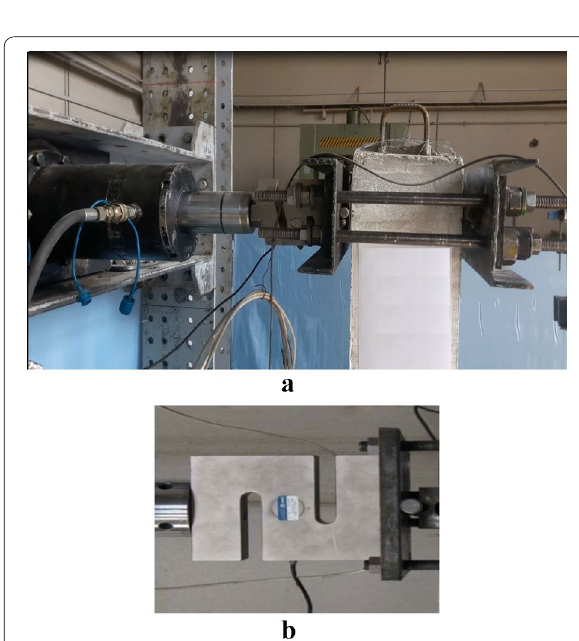
Fig. 13 The applied load on the specimen: a lateral cyclic displacement on beam end, b S-shape load